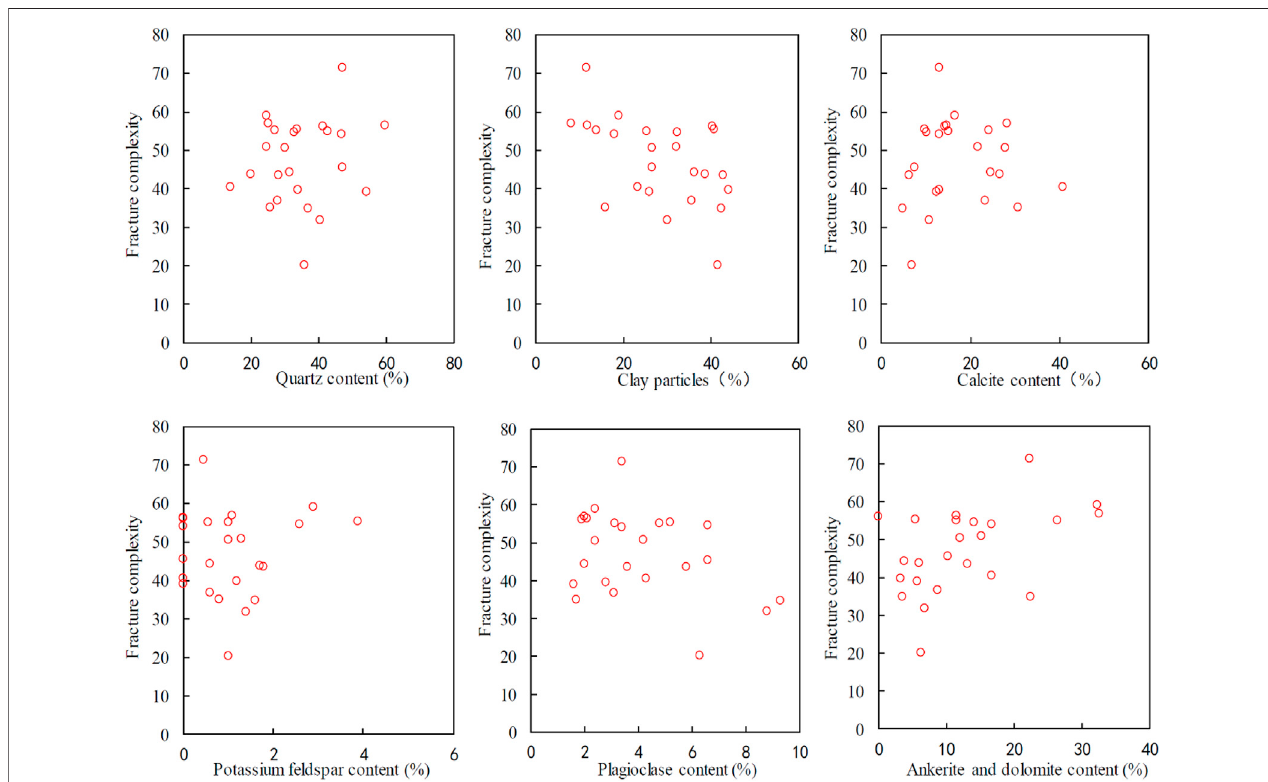
FIGURE 12 | Relationship between mineral content and fracture